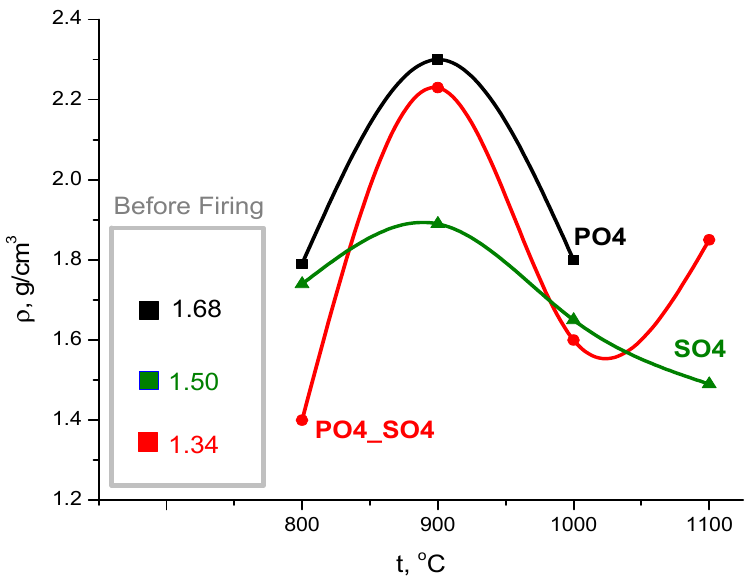
Figure 9. Temperature dependence of density of ceramic samples after firing.